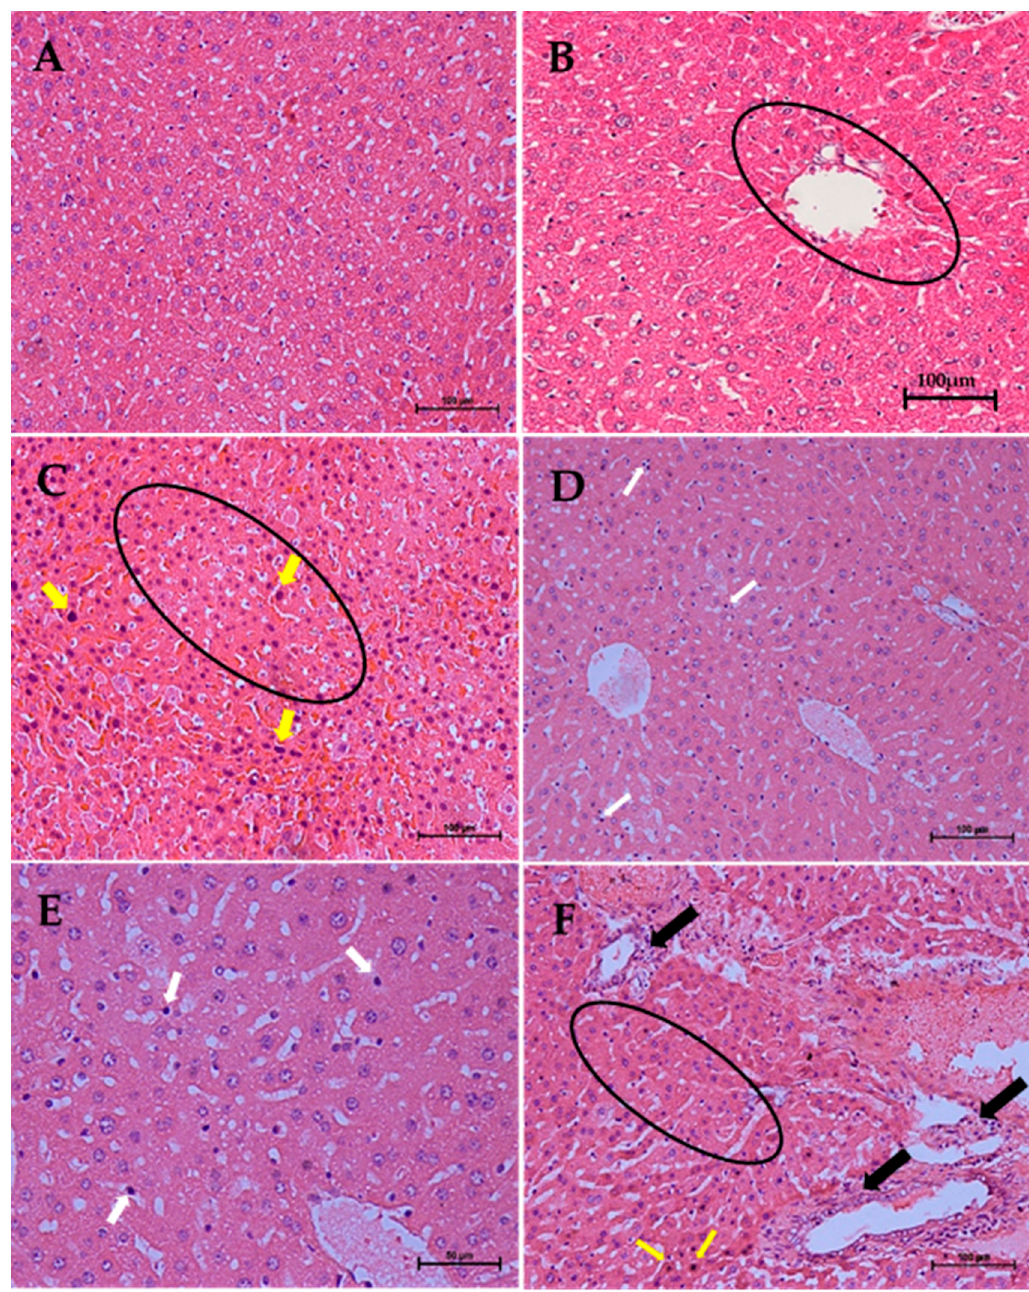
Figure 12. E ff ects of repeated oral administration of CELE for 28 days on the histology of liver of female ICR mice. Key: ( A ) Photomicrograph of a liver section (H&E stain × 200) from a mouse in group A (control) showing normal architecture of liver. ( B ) Photomicrograph of a liver section (H and E stain × 200) from a mouse in group A showing portal triad (encircled). ( C ) Photomicrograph of a liver section (H&E stain × 200) from a mouse in group E (1000 mg / kg CELE) showing eosinophilic cytoplasm (encircled) and pyknotic nuclei (yellow arrows) of the hepatocytes. ( D ) Photomicrograph of a liver section (H&E × 200) from a mouse in group E (1000 mg / kg) showing activated Kup ff er cells (white arrows). ( E ) Higher magnification (H and E stain × 400) of D showing activation of Kup ff er cells (white arrows). ( F ) Photomicrograph of a liver section (H and E stain × 200) from a mouse in group E (1000 mg / kg CELE), showing hepatitis (black arrows), eosinophilic cytoplasm (encircled) and pyknosis (yellow arrows) of the hepatocytes, H and E = haematoxylin and eosin, CELE = Clinacanthus nutans ethanolic leaf extract. Scale bars represent 100 µ